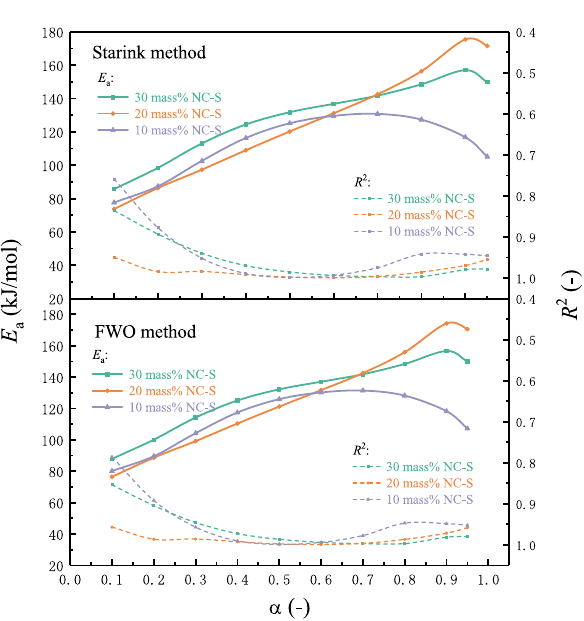
Figure 9. Comparison of NC-S’s E a calculation by differential and integral kinetic